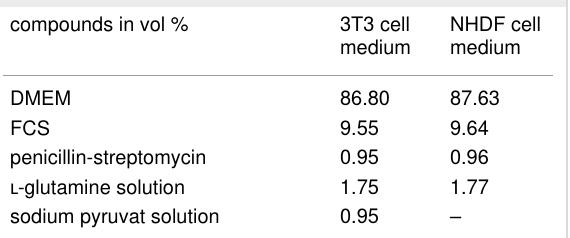
Table 3: Composition of the cell culture media. compounds in vol